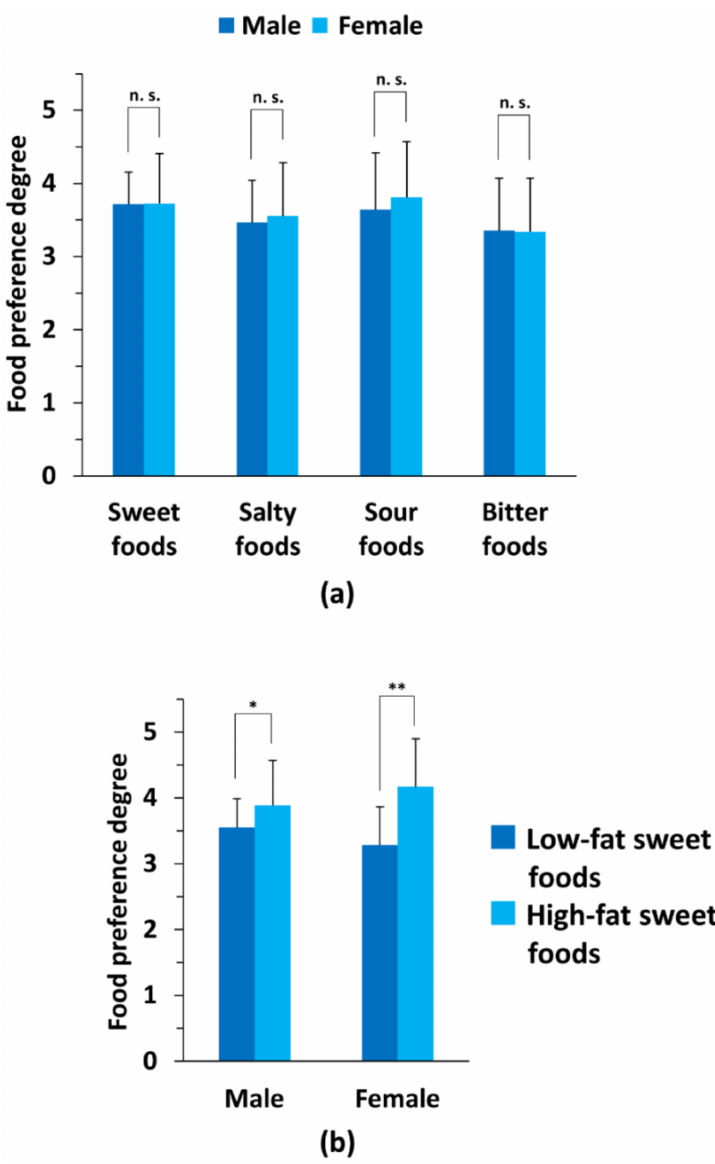
Figure 1. Comparison of primary taste preference degrees between the two sex subgroups. Using a self-reporting questionnaire to evaluate preferences for primary tastes, the subjects rated their degree of taste preference for a variety of tastants including salty, sour, sweet, and bitter on a scale of 1–5 as shown in Table 2, and as follows: scale 5, like very much; scale 4, like moderately; scale 3, neither like nor dislike; scale 2, dislike moderately; scale 1, dislike very much. ( a ) Comparison of the average taste preference between male and female subgroups. The summarized preferences for each primary food taste were compared between men and women ( n = 52). No significant differences in average taste preferences between males ( n = 26) and females ( n = 26) were observed based on Welch’s t -test for each tastant. ( b ) Comparison of average taste preference between low-fat and high-fat sweet foods in each sex subgroup. Significant differences were detected between the average taste preference degrees for low-fat and high-fat sweet foods in the female subgroup, but not in the male subgroup. Statistical differences between high-and low-fat sweet food groups were determined using Welch’s t -test. For ( a , b ), * p < 0.05; ** p < 0.01; n.s., not